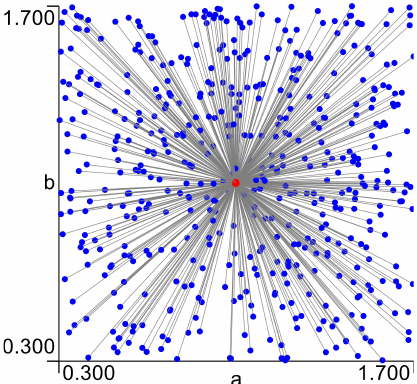
Figure 12: Randomised initial conditions shows that the optimum is globally unambiguous in Θ and obtained independent of the initial guess θ 0 . Results are shown only for data- set Step (other five sets show the same be- haviour).